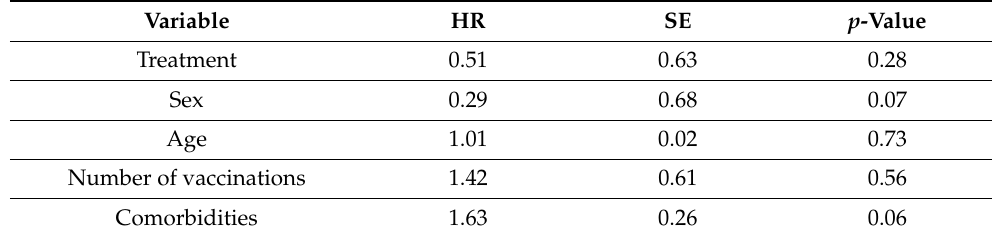
Figure 1. Kaplan–Meier curves of hospitalization in untreated and treated patients with hematologic malignancies and HSCT patients. Table 2. Multivariate Cox regression for 28-day hospital admission.